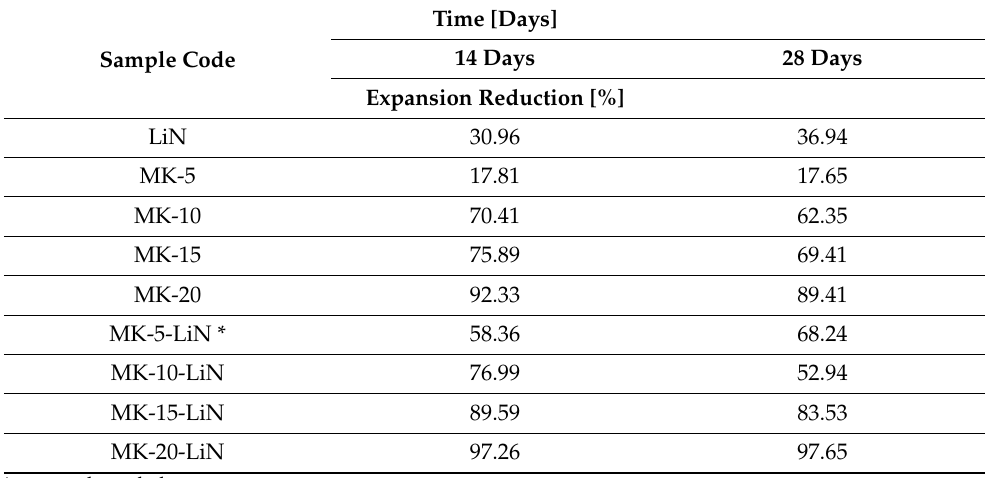
Table 3. Reduction of mortars expansion after 14 and 28 days, as against the control